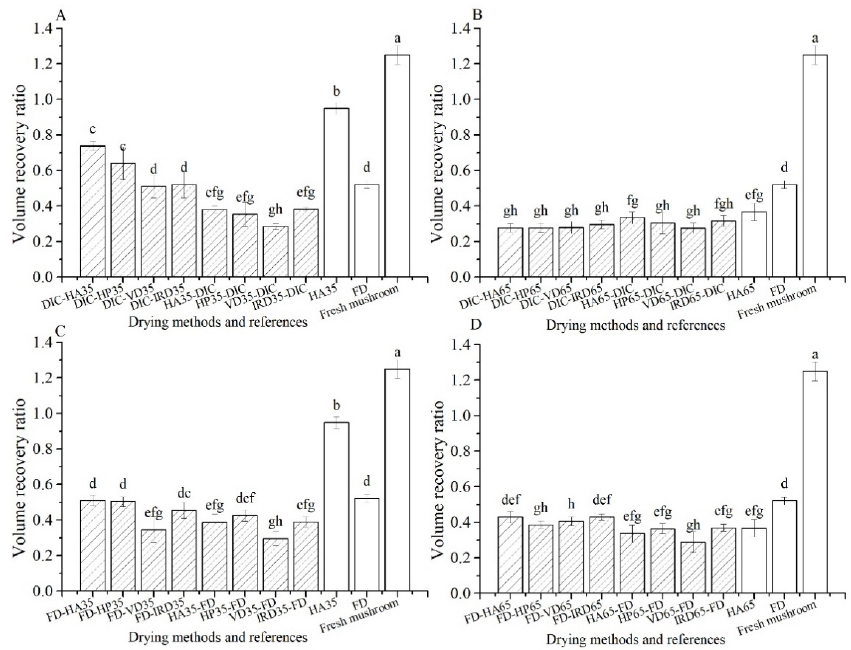
Figure 2. Volume recovery ratio of mushrooms after rehydration with different drying methods ( ) and references ( □ ). ( A–D ): group names as shown in Table1.